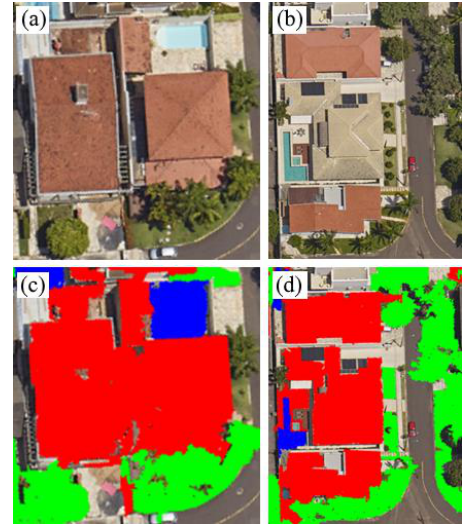
Figure 6 - Object extraction for regions (a) and (b) and the respective results in (c) and (d). Legend: buildings (red), trees (green), swimming pool (blue).